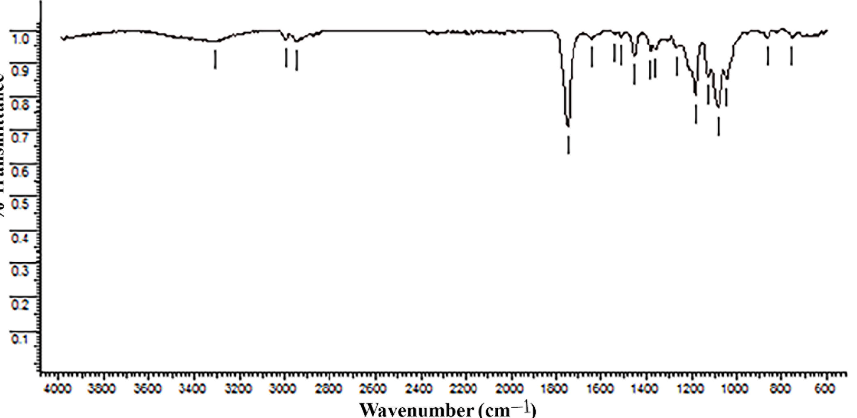
Figure 13. FT-IR spectra of Arboform ® LV3 Nature reinforced with aramid fibers.